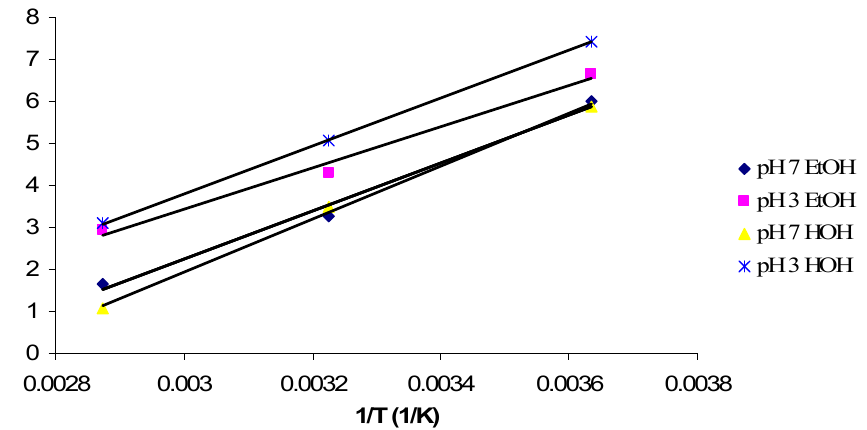
Figure 3. The Arrhenius plots for degradation of anthocyanins in cranberrybush fruits extracts.